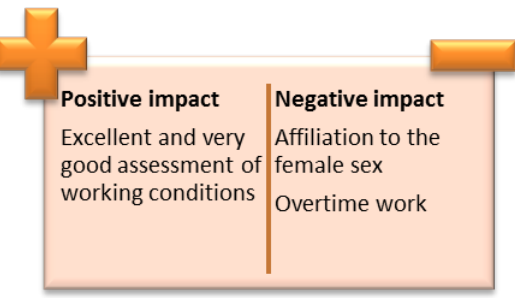
Figure 2. Factors determining the beneficial effects of the quality of the working environment on health Source: Own estimates of the target survey database